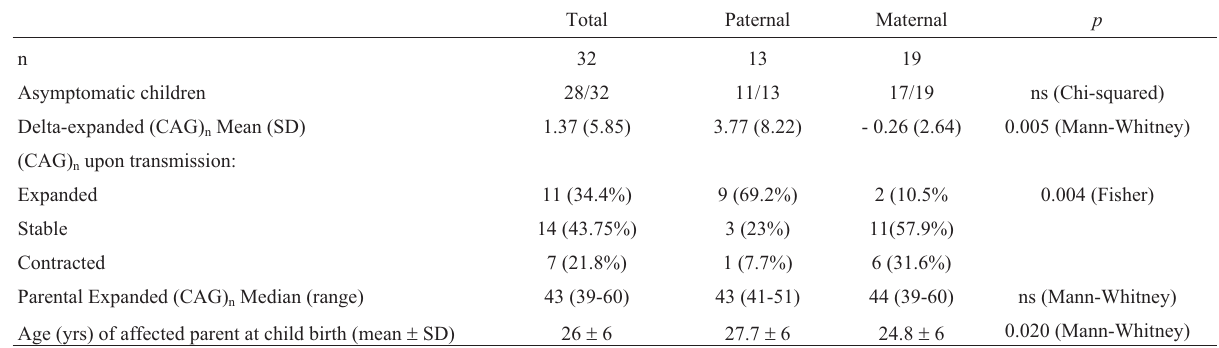
Total Paternal Maternal p